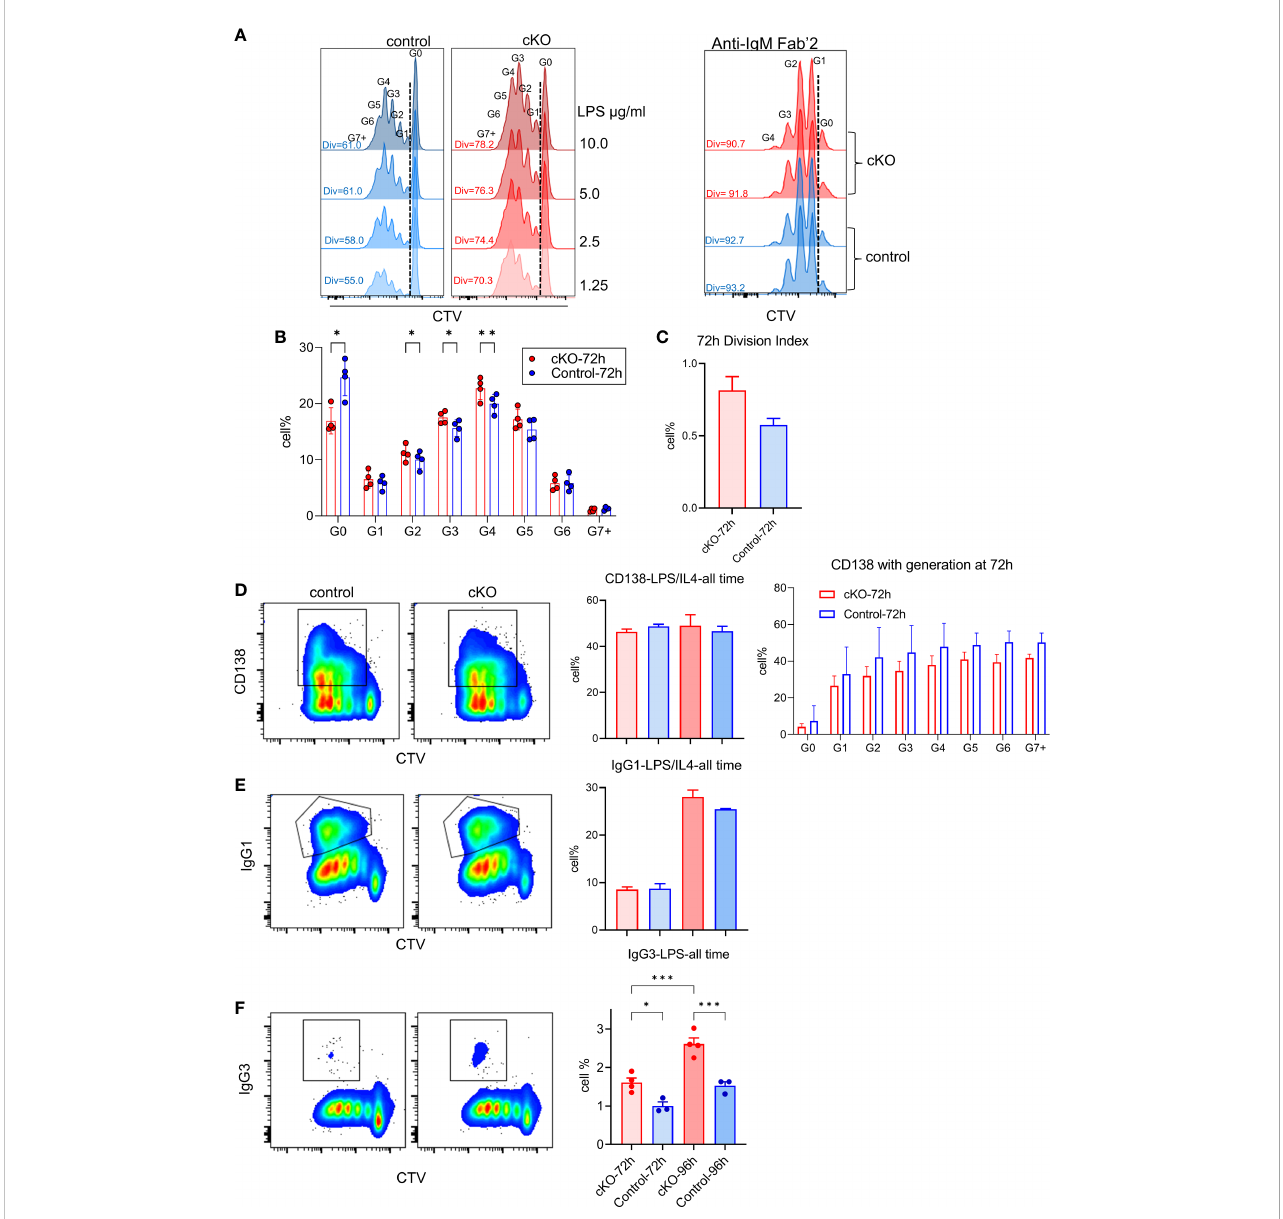
FIGURE 8 Functional characterization of splenic B cells from WT and cKO derived mice. Splenic B cells from WT and cKO mice were activated with LPS (1.25, 2.5, 5 and 10µg/ml), F(ab`)2 anti-IgM (10µg/ml) or LPS (10µg/ml) plus IL-4 (20ng/ml) for the indicated time points followed by fl ow cytometry analysis. (A) Representative fl ow cytometry plot of Cell Trace Violet (CTV) dilution after 72 hours of LPS (10µg/ml n = 4, other concentrations n = 2) or anti-IgM (n = 2) activation. The Div numbers indicate the percentages of divided cells for the indicated mouse strain. Numbers above the CTV peaks refer to the cell generation (G0 – G7+) (B) Cell percentages at each cell division after 72 hours of LPS activation. Bars represent the mean +/- SEM obtained from 4 independent experiments and p values are shown for paired t-test corrected for multiple comparisons. (C) Division Index was calculated for cKO and WT B cells after 72 hours using FlowJo proliferation platform. (D, E) Representative fl ow cytometry plot of CD138 (D) or IgG1 (E) versus CTV for WT and cKO (left) after 96 hours of LPS plus IL-4 activation. Gating of CD138 + and IgG1 + cells are indicated. The bar plot on the right shows the average of the CD138 + (and the CD138 + cell percentages per cell division) or IgG1 + cell percentages at the indicated times. (F) Representative fl ow cytometry plot of IgG3 versus CTV after 96 hours of LPS activation and the bar plot shows the IgG3 + cell percentages at the indicated time points. Data represent